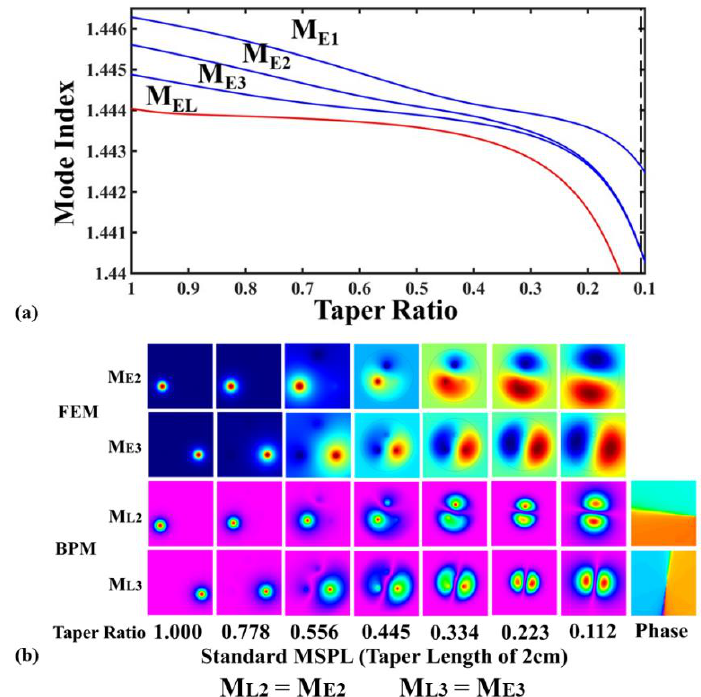
Figure 2. ( a ) The FEM simulation mode indexes evolution along the taper of the standard MSPL. M E1 , M E2 , and M E3 represent the first- and the two second-order eigenmodes. The M EL represents the leaky mode simulated by FEM. The black dashed line indicates the taper ratio of 0.112. ( b ) The comparison of the FEM/BPM simulated mode profiles at different positions along the taper when selectively injecting light into the Fiber 2 and 3 cores of the standard MSPL. M L1 , M L2 , and M L3 represent the local modes when individually injecting light into Fiber 1, 2, or 3 cores, respectively. BPM: beam propagation method; FEM: finite element method; MSPL: mode-selective photonic lantern.